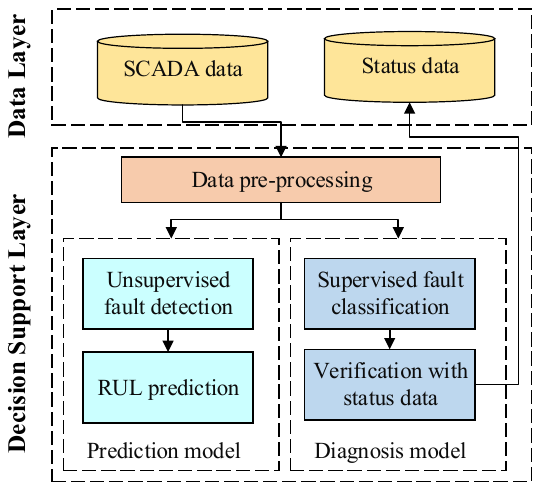
Figure 4. Overview of the integrated wind turbine generator fault prediction and diagnosis